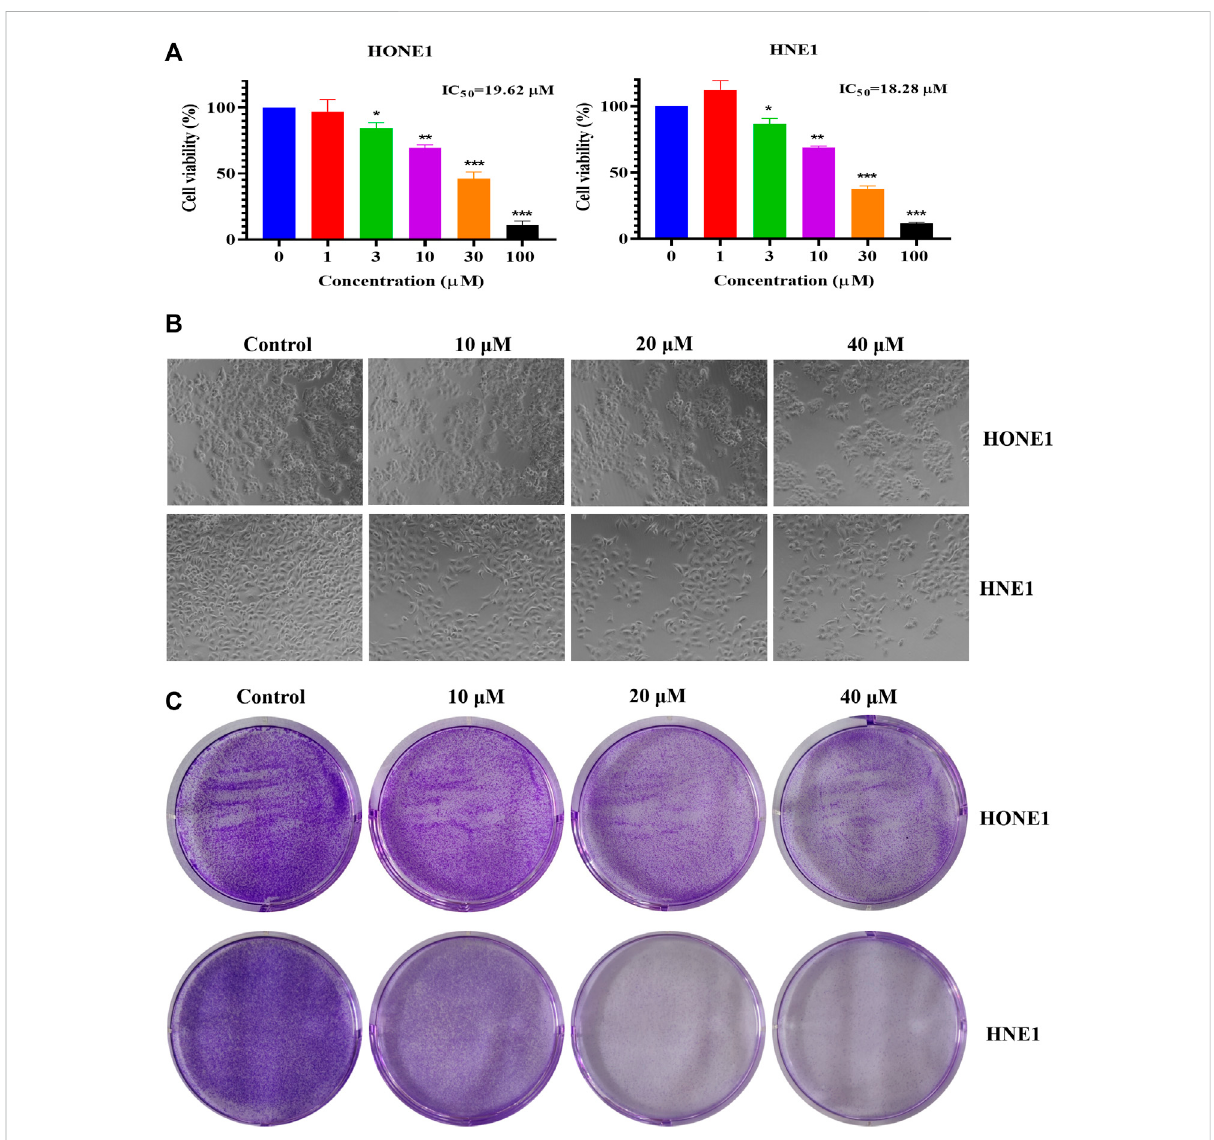
FIGURE 1 EffectsoficaritinonHONE1andHNE1cellproliferation. (A)